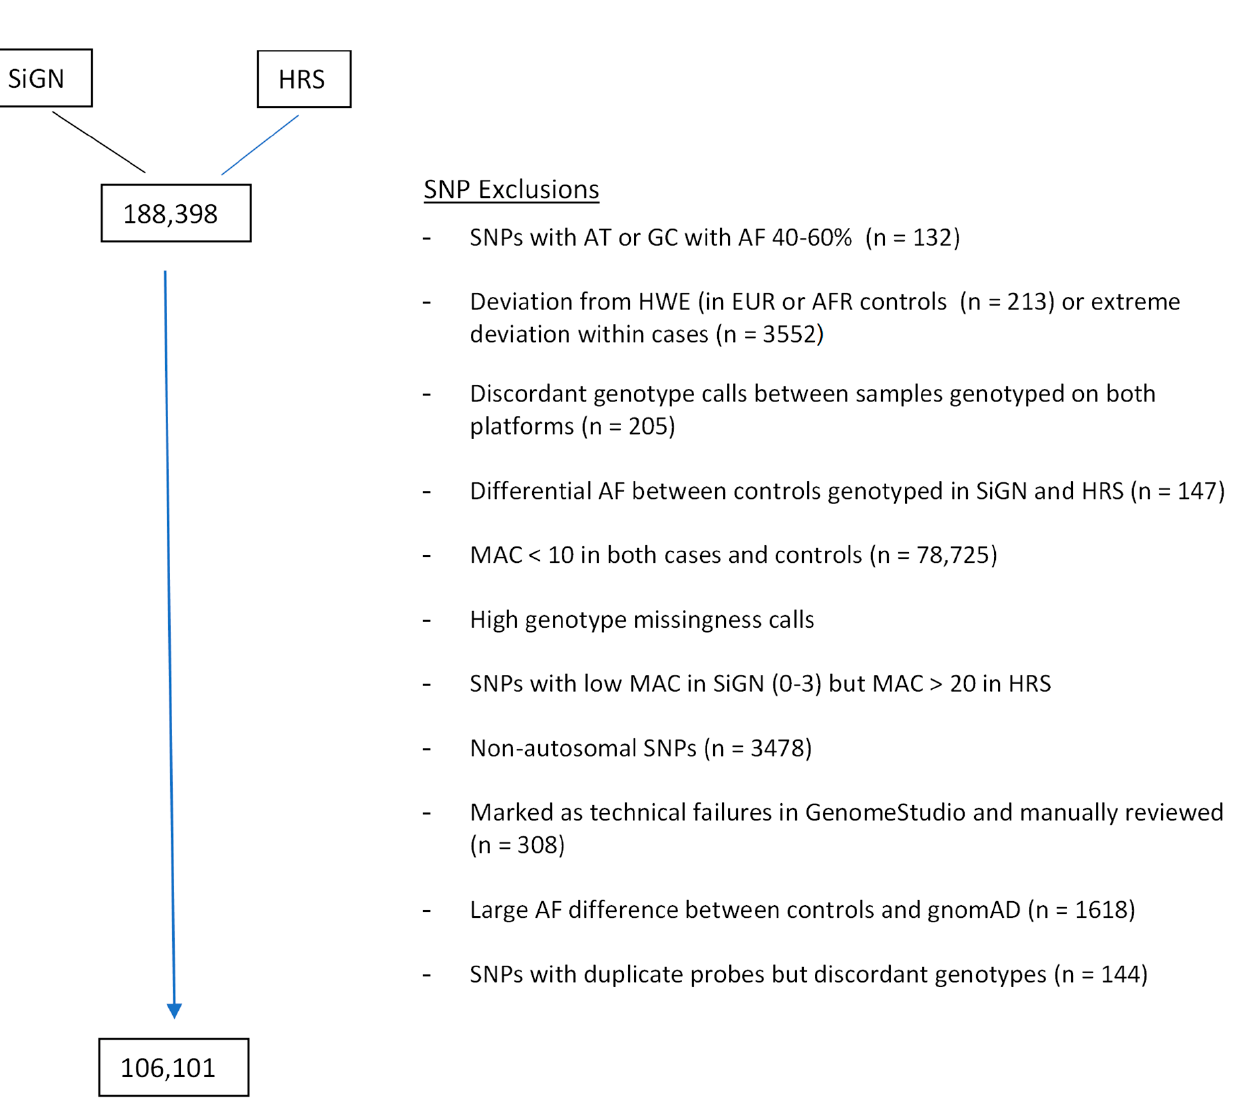
Figure 1. Stage 1 variant quality control pipeline. 188,398 SNPs merged between the SIGN and HRS arrays. 82,297 SNPs excluded, leaving 106,101 SNPs for analysis (see Table S1 for specific filtering thresholds at each QC step). Table 2. SNP Quality control filters.